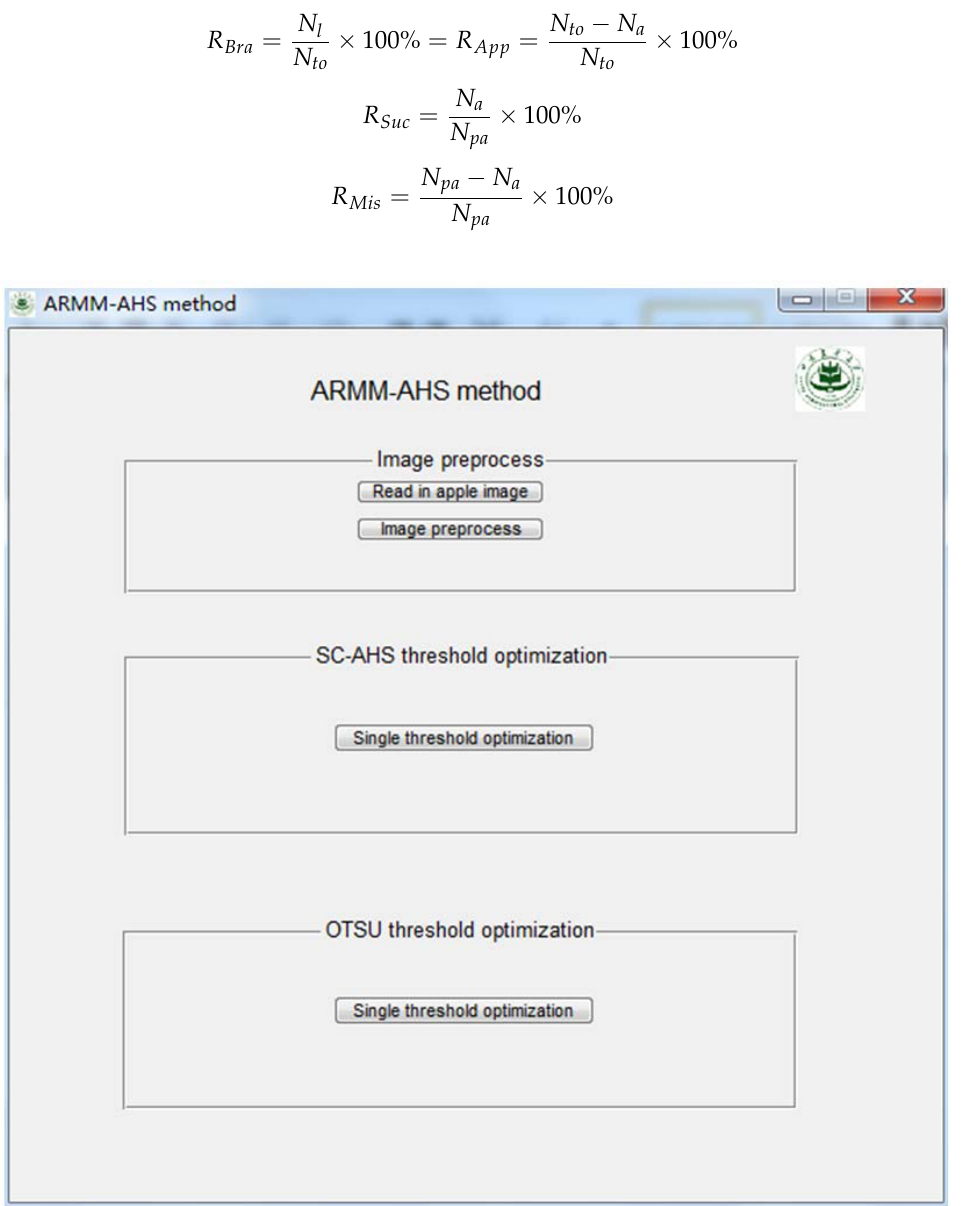
Figure 14. Main interface of the apple image segmentation program.